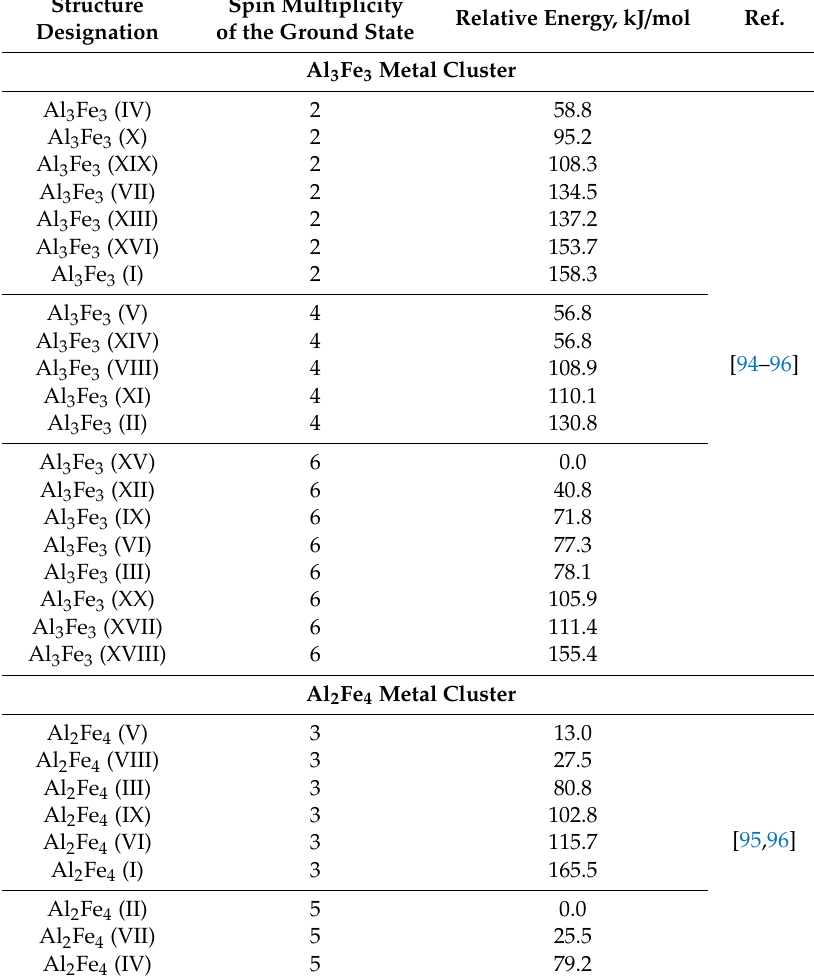
Table 8. Relative energies and spin multiplicities of the ground states of various isomers of metal clusters Al 3 Fe 3 and Al 2 Fe 4 . Roman numerals in the table are the designations of these metal clusters presented in the original works.